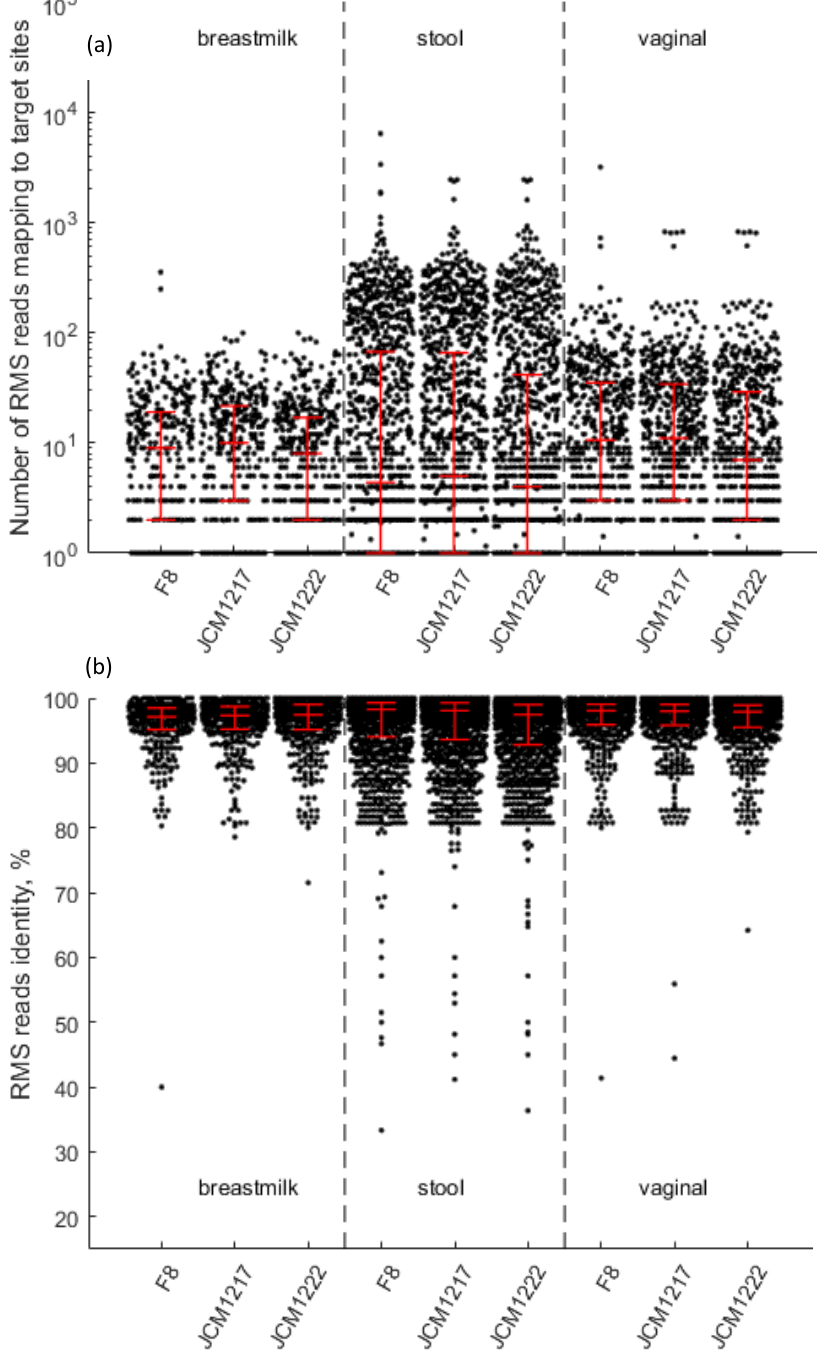
Figure 2. Mapping of raw RMS reads from breast milk, stool and vaginal swab pools towards whole genome sequences of B. longum . F8 and JCM1217— B. longum ssp. longum ; JCM1222— B. longum ssp. infantis . Median values, as well as 25th and 75th percentile, are depicted in red; ( a ) Coverage of mapped genome regions; ( b ) Pairwise identity of raw RMS reads towards mapped genome regions.